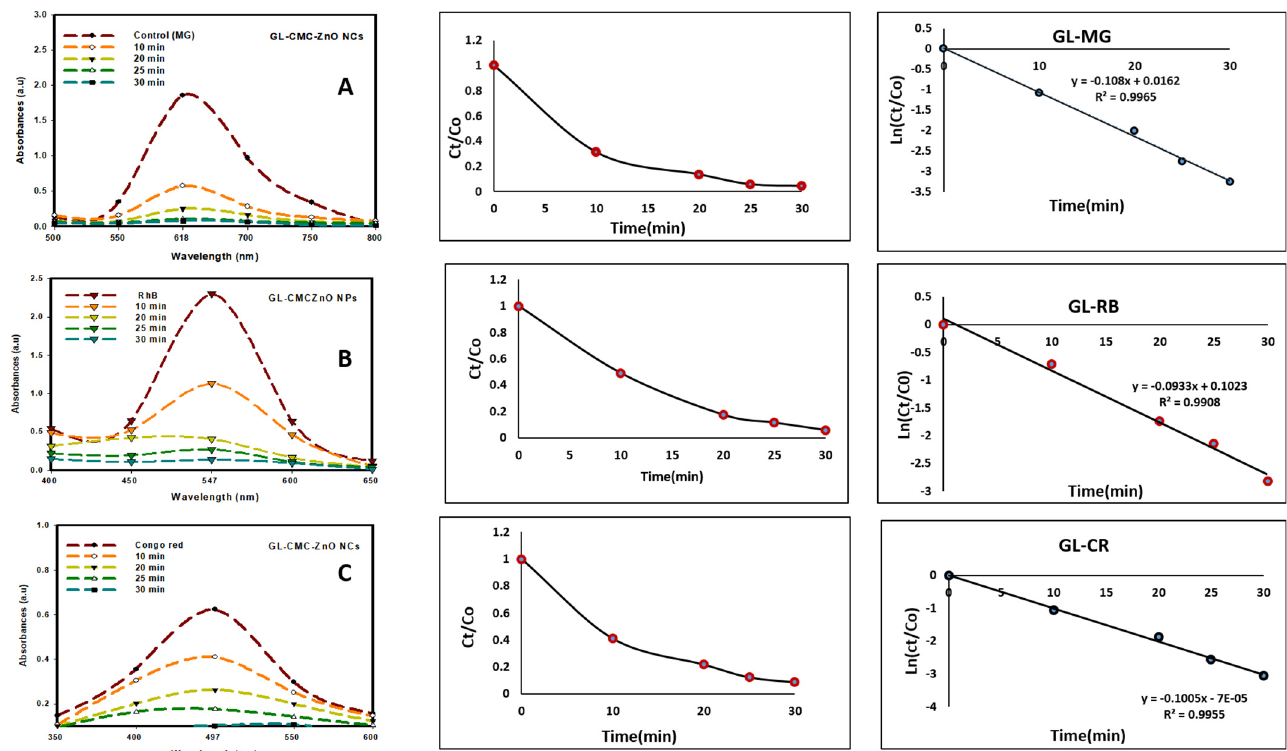
Figure 9. Photocatalytic activities of GL–CMC–ZnO NCs under UV irradiation with the kinetic study: ( A ) malachite green (MG) degradation with kinetic study; ( B ) Rhodamine B (RB) dye degradation with kinetic study; ( C ) Congo red (CR) dye degradation with kinetic study.